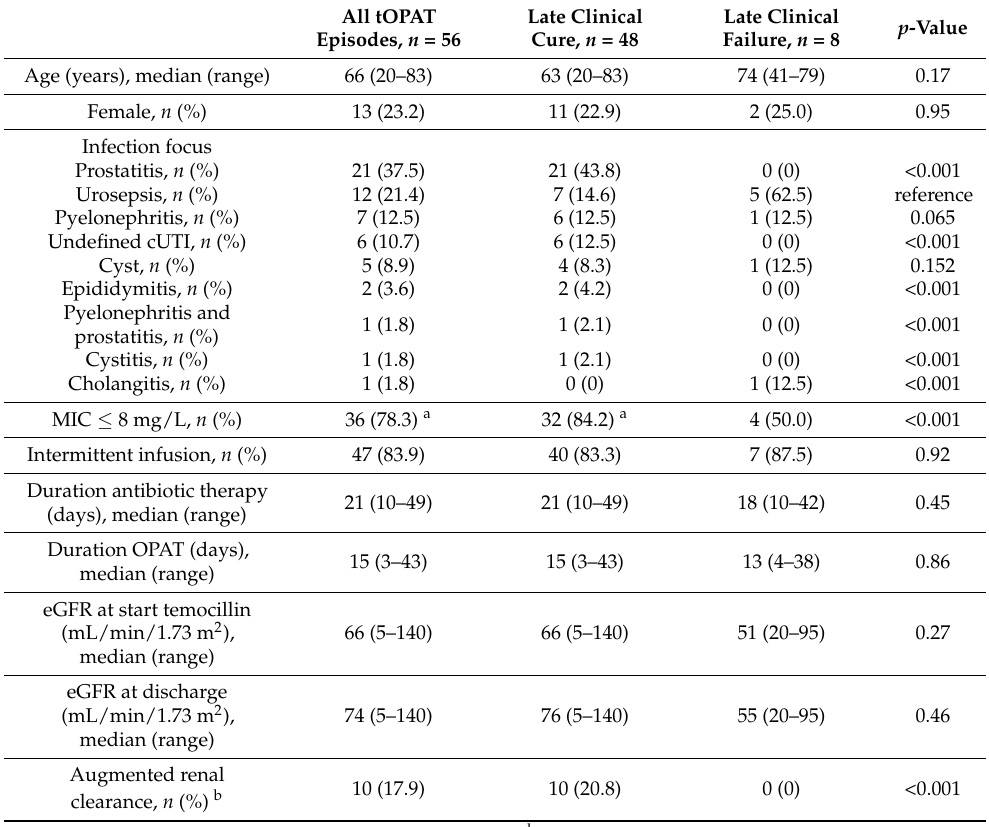
Table 2. Demographic, clinical and treatment-related data in the total population and in the tOPAT episodes ( n = 56) with late clinical cure and late clinical failure,